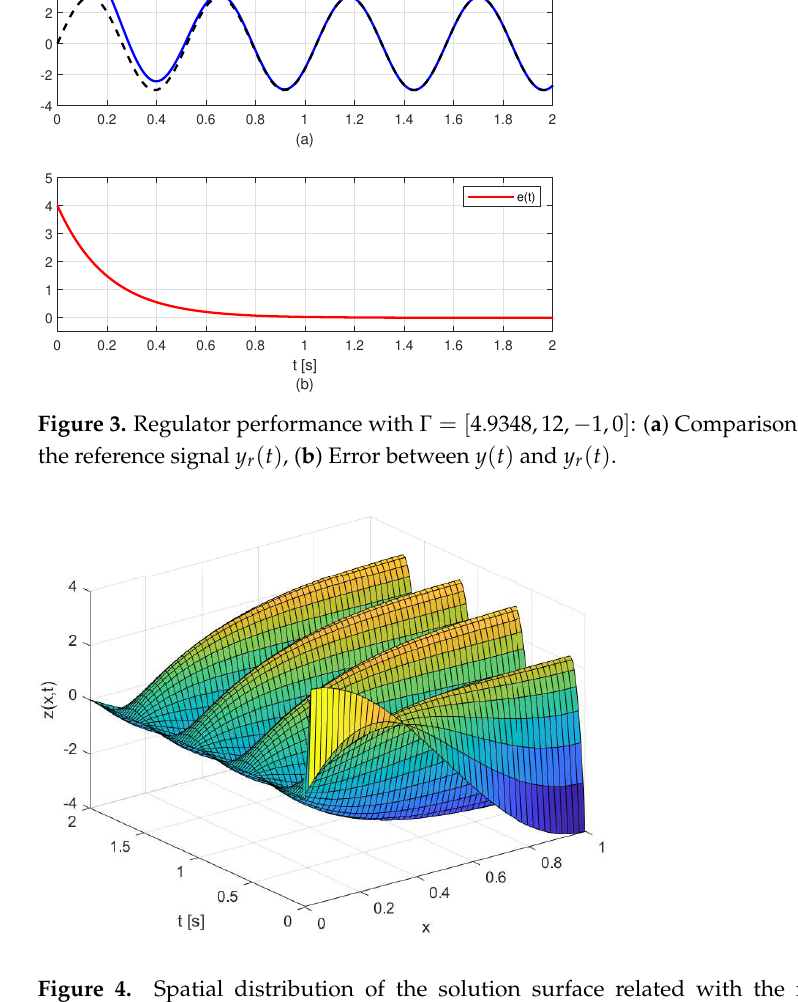
Figure 4. Spatial distribution of the solution surface related with the rejection of harmonic